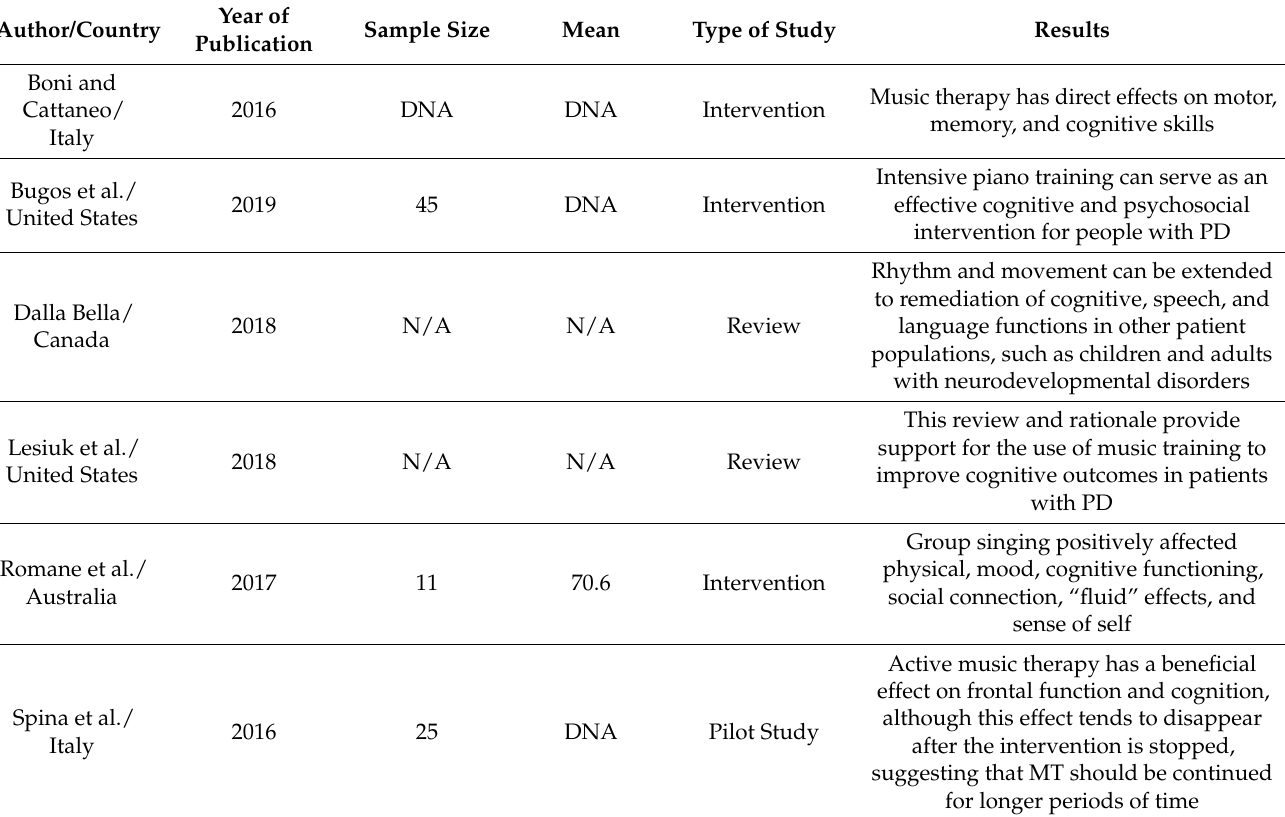
Table 7. Articles addressing the effects of music therapy on the cognitive